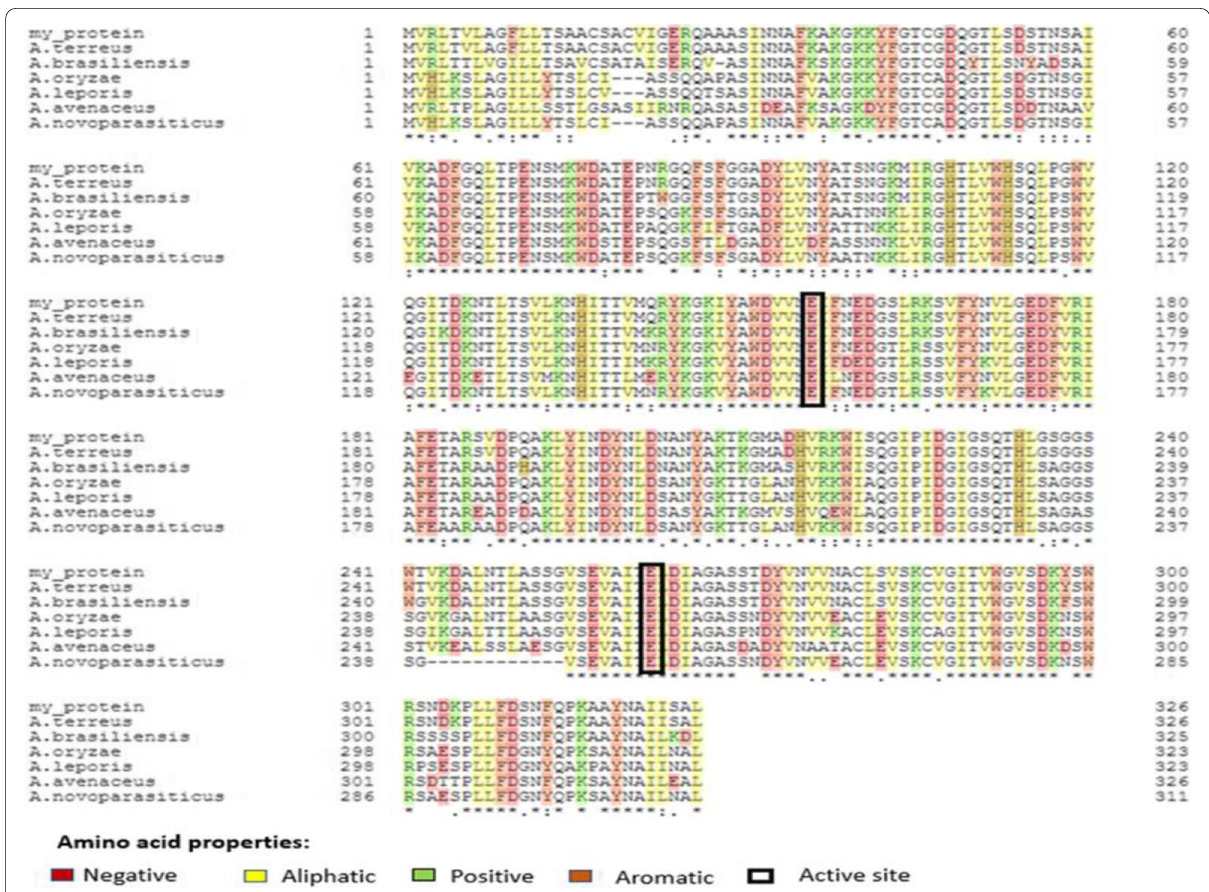
Fig. 17 Multiple sequence alignment of amino acids for xylanase gene from A. terreus strain RGS. Eg‑NRC (xyl) gene and other xylanase genes